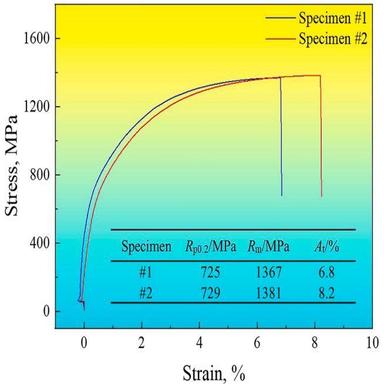
The engineering stress-strain curves of the as-prepared advanced high strength steel.